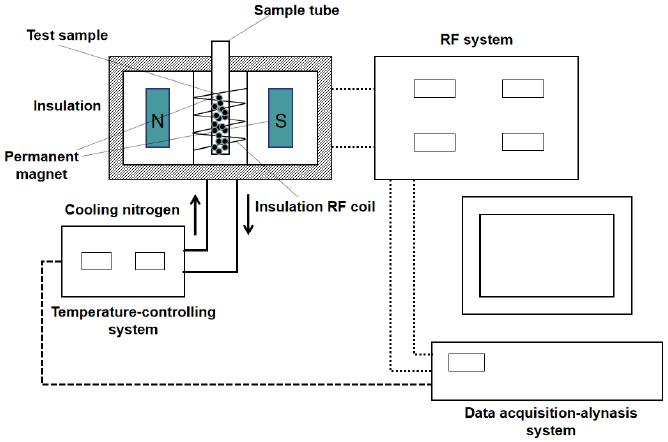
Figure 2. The structural principles of the NMR